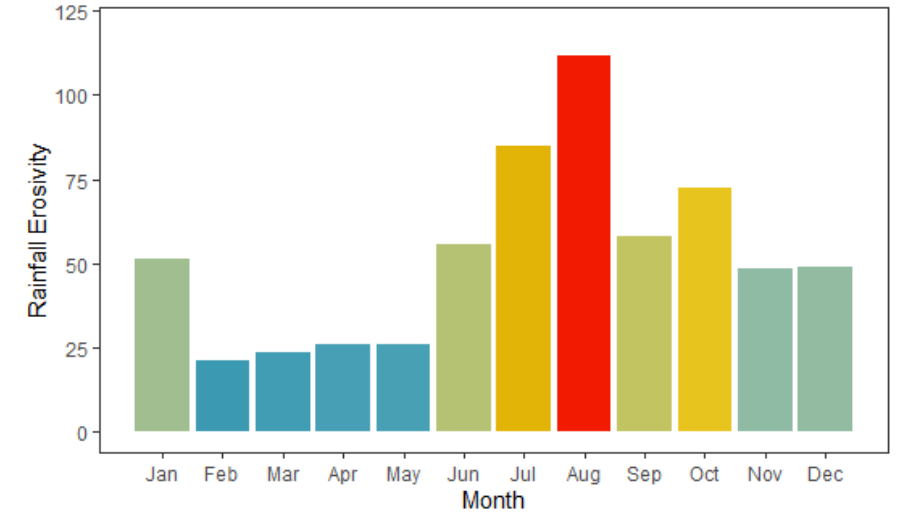
Figure 7. Monthly rainfall erosivity at Magna (MJmmha − 1 h − 1 y − 1